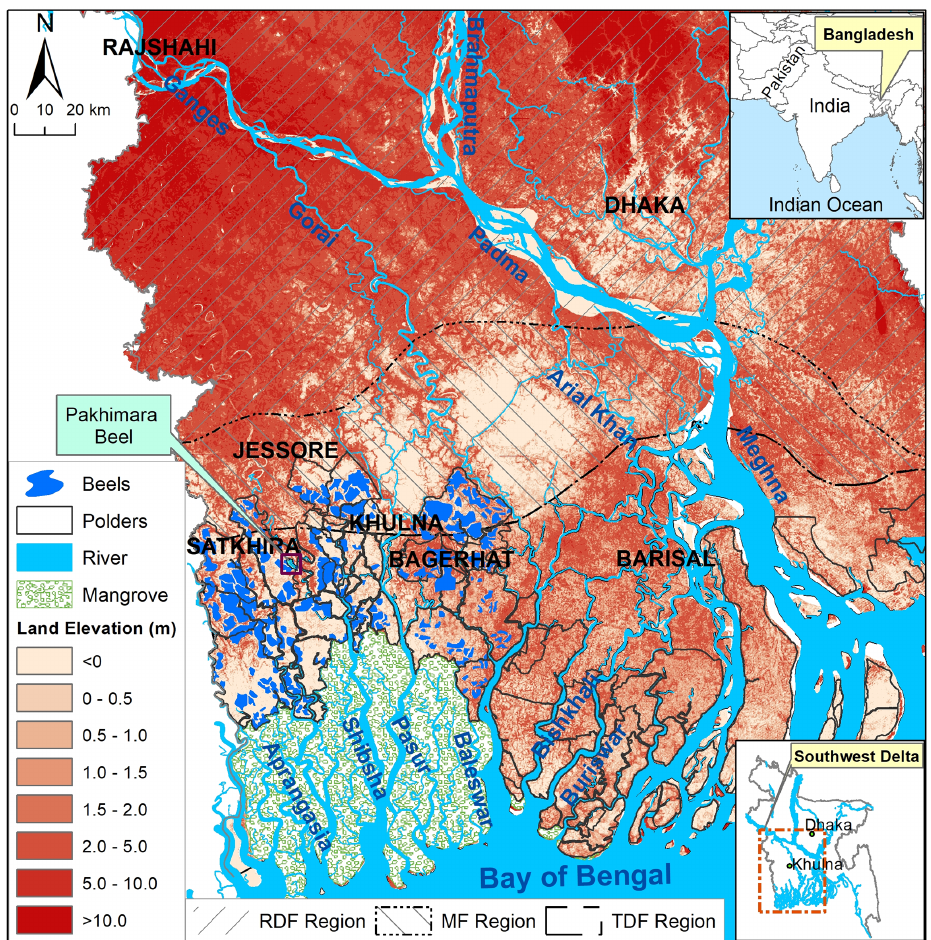
Figure 1. Polders and beels of southwestern Bangladesh. Elevation data are from the coastal DEM (Kulp and Strauss, 2018). Beel data are from Adnan et al.